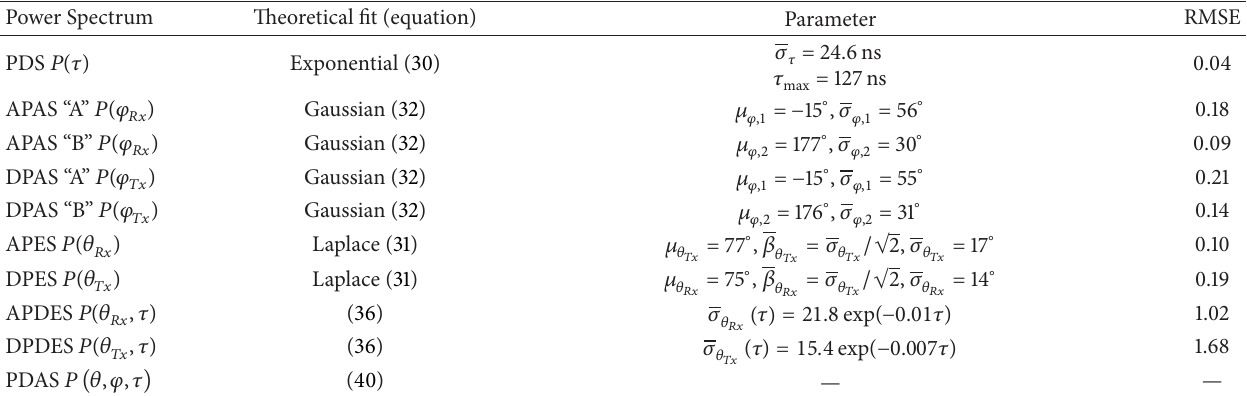
Table 6: The model of channel power spectra and their